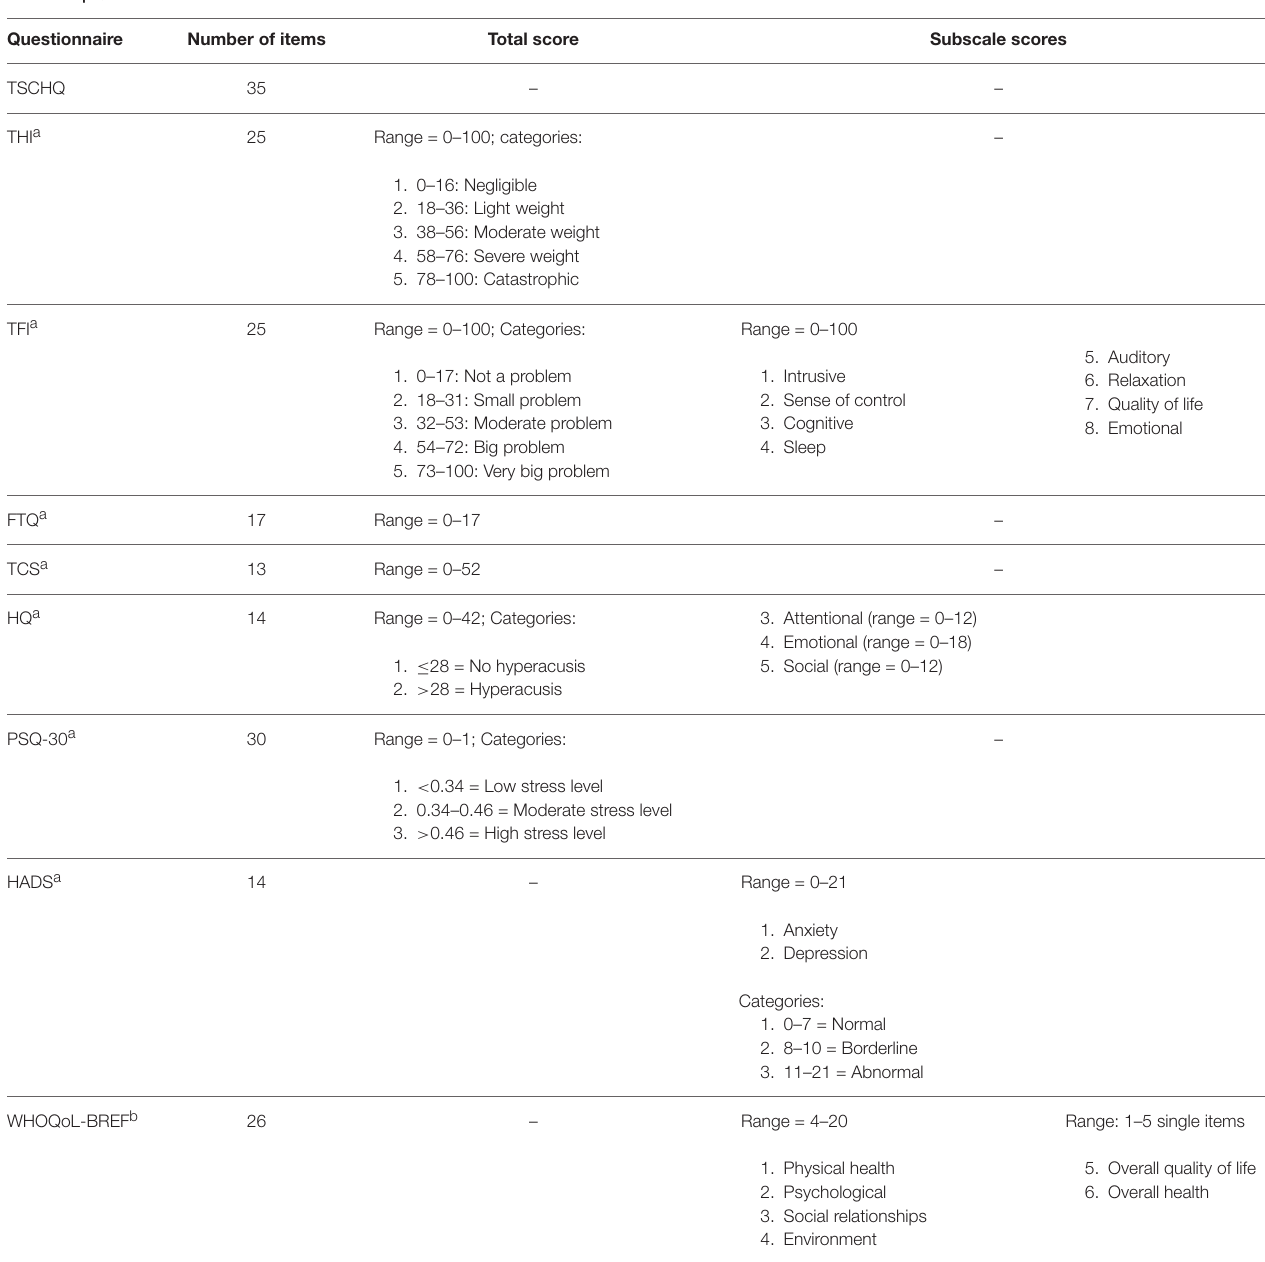
TABLE 1 | Questionnaire